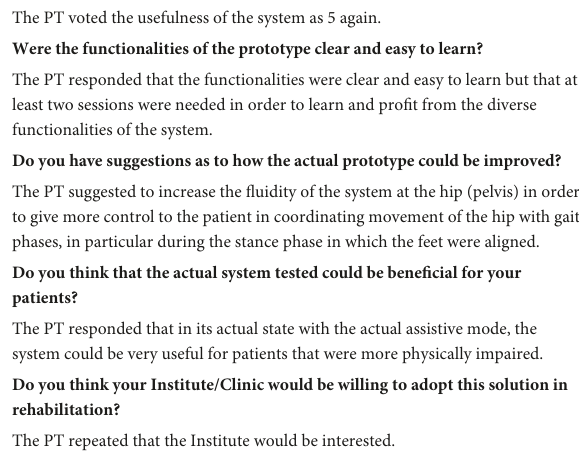
Which aspect of the exoskeleton did you like the most and why?